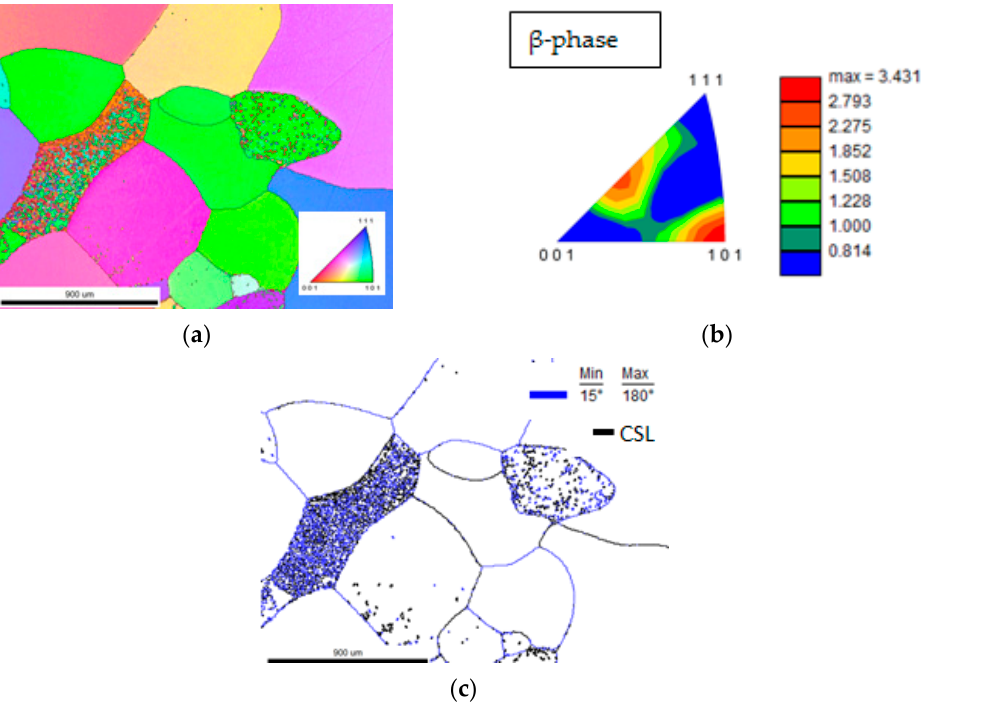
Figure 4. CuZn42 alloy in the heat treated condition. ( a ) Inverse pole figure (IPF-Z) map and ( b ) texture plot. ( c ) Misorientation map. The poor quality of the map was attributed to fine domain size within the macroscopic β -phase grains. Unit: µ